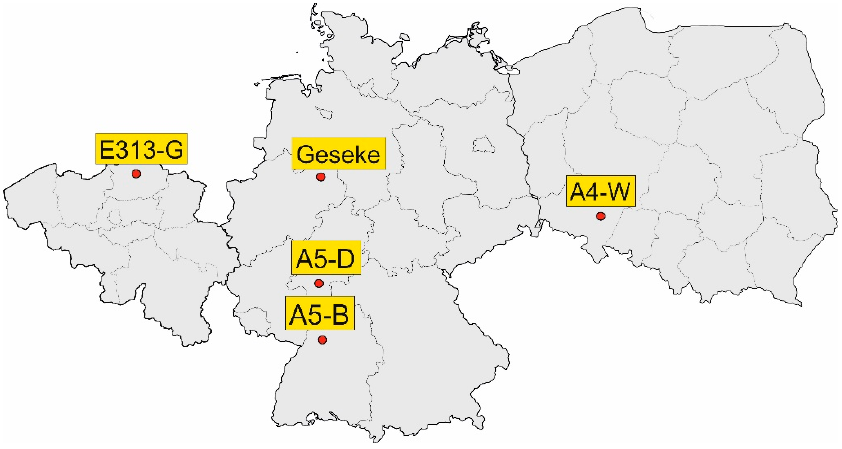
Figure 3. Examined test tracks in CRCP.